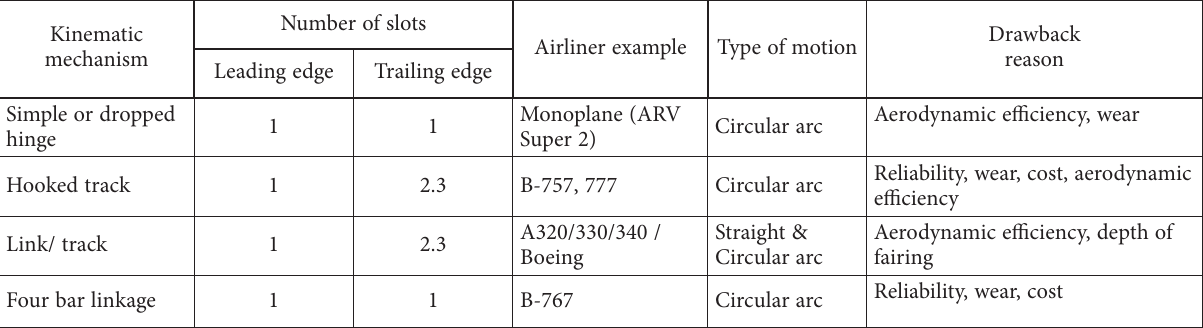
Table 1. Types of kinematic mechanisms in a high lift